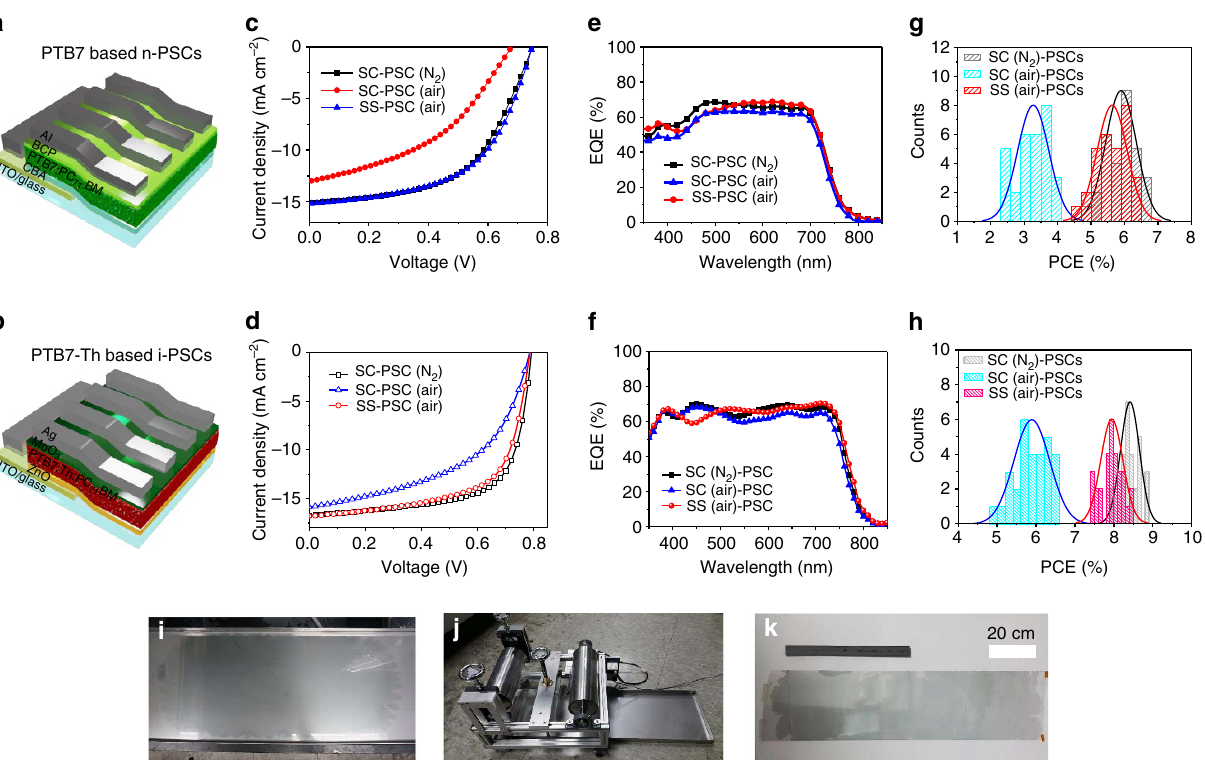
Figure 4 | Fabrication of organic solar cells using SS films and potential for scalable process. ( a , b ) Device structure of n-PSC (PTB7:PC 71 BM) and i-PSC (PTB7-Th:PC 71 BM); ( c – f ) J–V characteristics and EQE spectra of PTB7-based ( c , e ) and PTB7-based PSCs ( d , f ) under AM 1.5G 100mWcm (cid:2) 2 illumination. ( g,h ) statistics for PCEs of 30 samples. ( i ) Formation of a single SS film on a large water bath (30 (cid:3) 120cm 2 ). ( j ) Homemade R2R coating system for large- scale transfer on flexible substrates. ( k ) 25 (cid:3) 100cm 2 PET film coated with a SS-PTB7:PC 71 BM film.